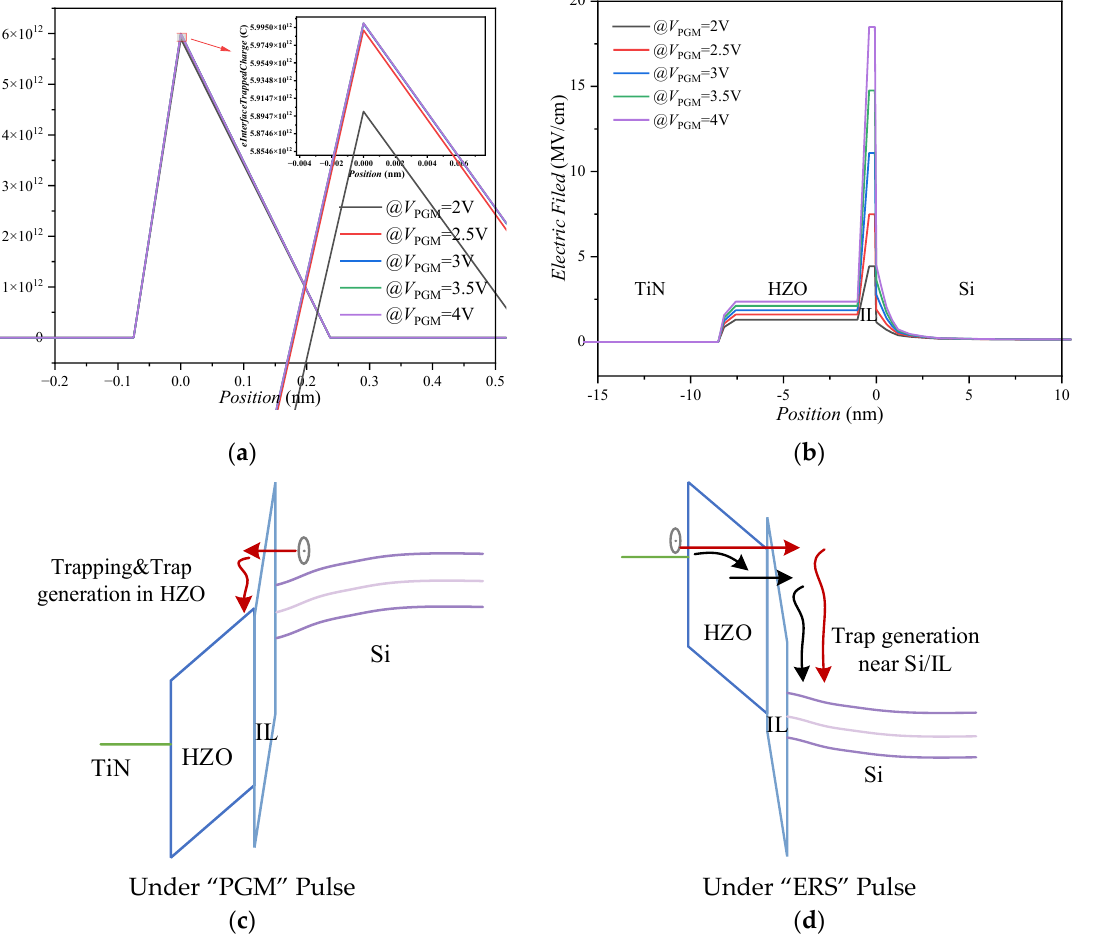
Figure 13. ( a ) Interface trapped charge varies with the voltage of program pulse. ( b ) Electrical field and conduction band diagram in FeFET using TCAD tools at the various voltages of the program pulse. Schematic diagram of energy band under ( c ) PGM and ( d ) ERS pulses, where the red and black arrows indicate that electrons flow through HZO through FN tunneling and trap-assisted conduction, respectively